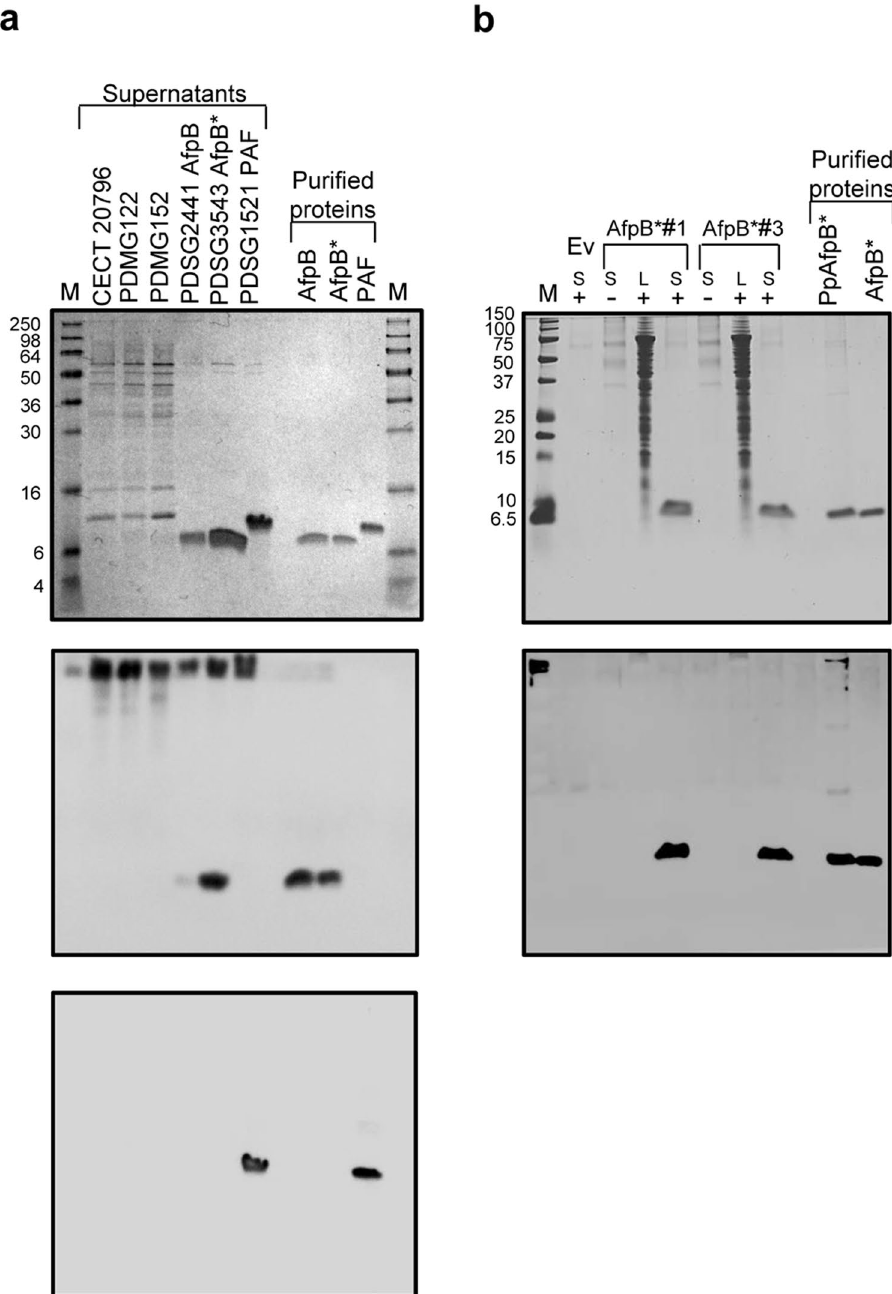
Figure 3. Analyses of supernatants of AfpB-producing strains and purified proteins by SDS-PAGE and Western blot. ( a ) P . digitatum supernatants (4–8 µ g of total protein loaded per lane) and purified proteins (1 µ g loaded per lane) visualized by Coomassie blue staining (top panel); M: SeeBlue ® Pre-Stained Protein Standard, supernatants of wild-type strain CECT 20796, deletion strain PDMG122 Δ afpB , constitutive expression strain PDMG152 afpB c , AfpB producer strain PDSG2441, AfpB * producer strain PDSG3543 and PAF producer strain PDSG1521. Immunoblot analyses of samples described above, using anti-PAFB (middle panel) and anti- PAF (bottom panel) antibodies. ( b ) P . pastoris supernatants (15 µ g loaded per lane), cell lysates (50 µ g loaded per lane) and purified proteins (1 µ g loaded per lane) visualized by Coomassie blue staining (top panel). M: Precision Plus Protein Standard; AfpB * #1 and AfpB * #3: selected PpAfpB * producer colonies; Ev: control strain transformed with empty vector pPICZ α A. S: supernatant; L: cell lysate; under non-induced conditions ( − ) or induced conditions ( + ). Immunoblot analyses of samples were performed as described above using anti-PAFB antibodies (bottom